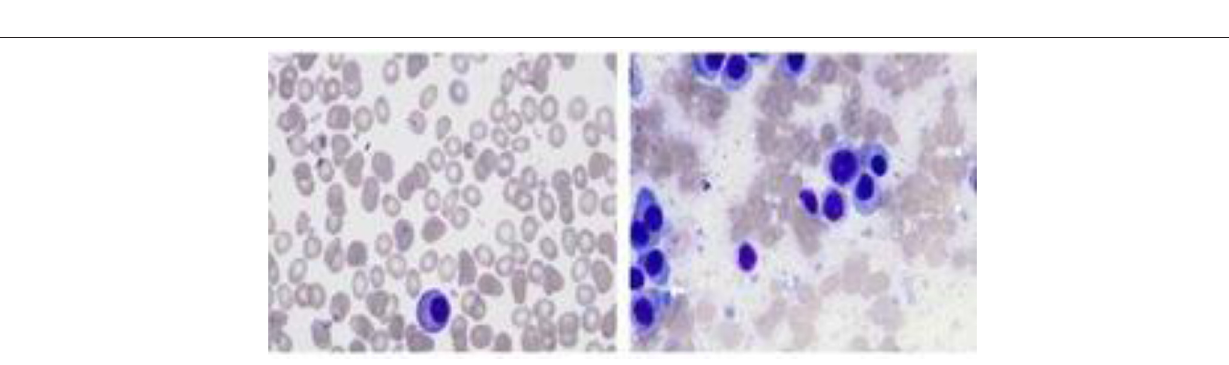
more frequent in men than in women ( ∼ 1.4:1). The risk